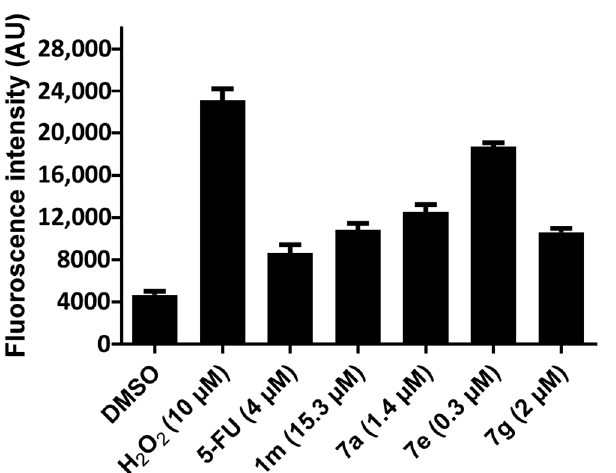
Medicines 2021 , 8 , x FOR PEER REVIEW Figure 4. Evaluation of 1m , 7a , e , and g on the mitochondrial membrane potential of HCT 116 cells.